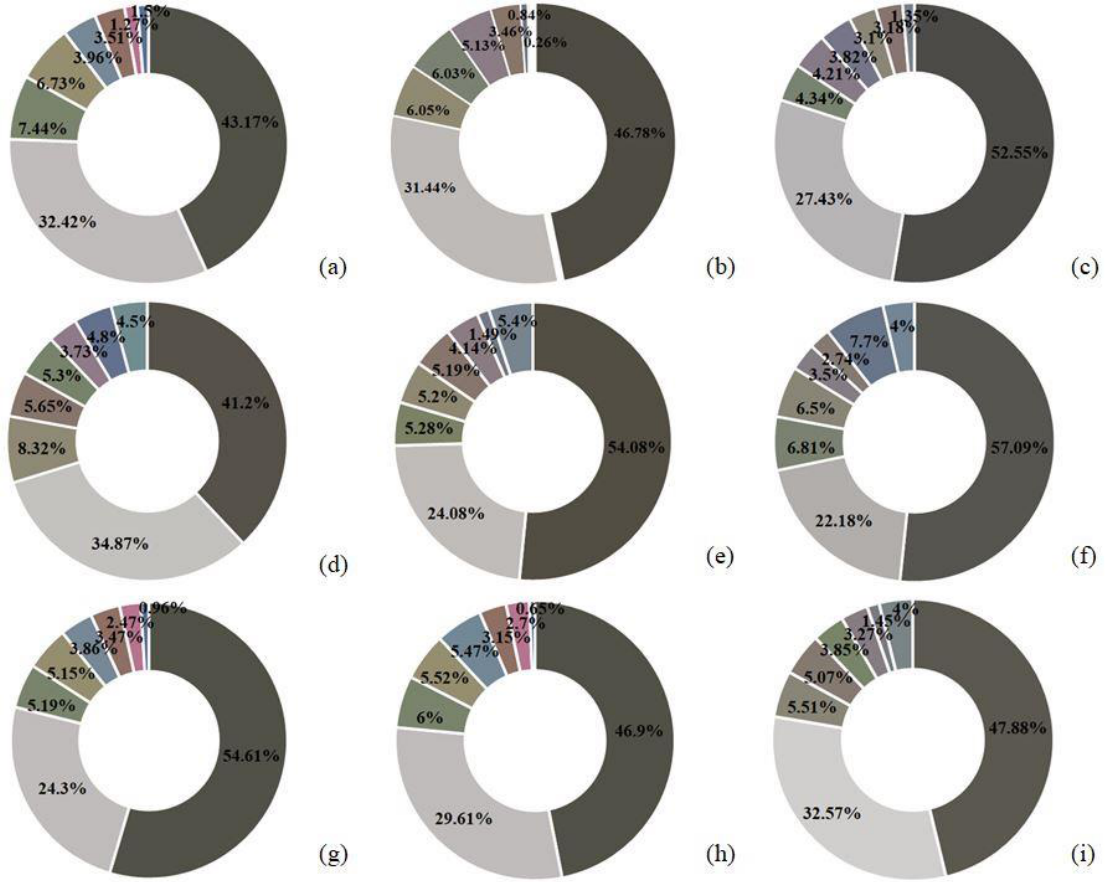
Figure 9. Landscape color rings along different roads. ( a ) Color ring of Minxing Road; ( b ) Color ring of Hongyi Road; ( c ) Color ring of Beiyuan Road; ( d ) Color ring of Wenhua Avenue; ( e ) Color ring of Zhanglan Road; ( f ) Color ring of Xingtan East Road; ( g ) Color ring of Lvyang Road; ( h ) Color ring of Tinghe Road; ( i ) Color ring of Yuzhang Road.